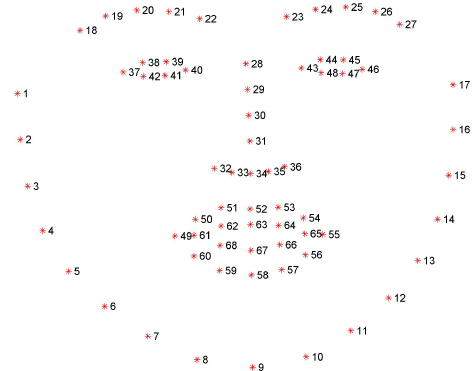
Figure 2. Key-point annotation in 300W-LP.